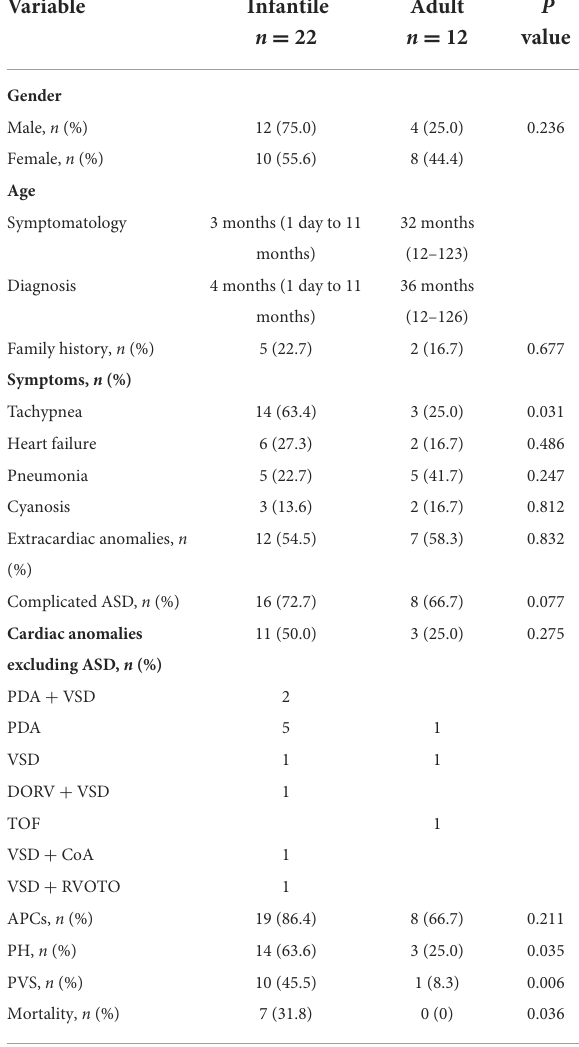
TABLE 1 Demographic and clinical characteristics of the study